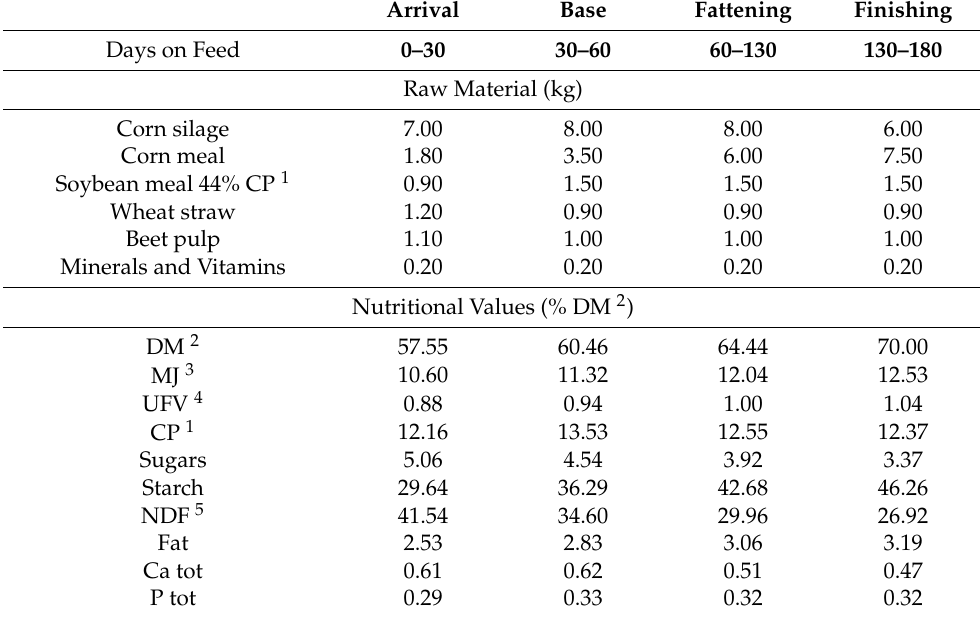
Table 2. Predicted diet composition and nutritional value, calculated by the rationing software (Plurimix). Arrival Base Fattening Finishing Days on